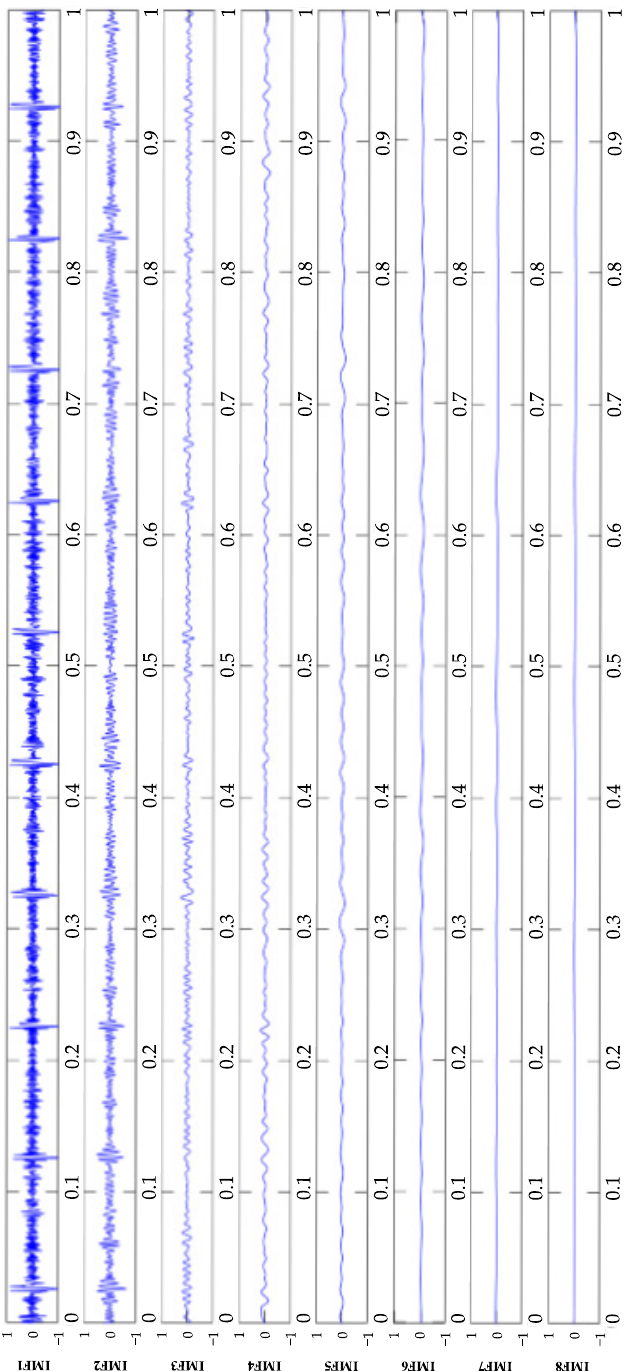
Figure 9. EEMD decomposition results of simulated signals.